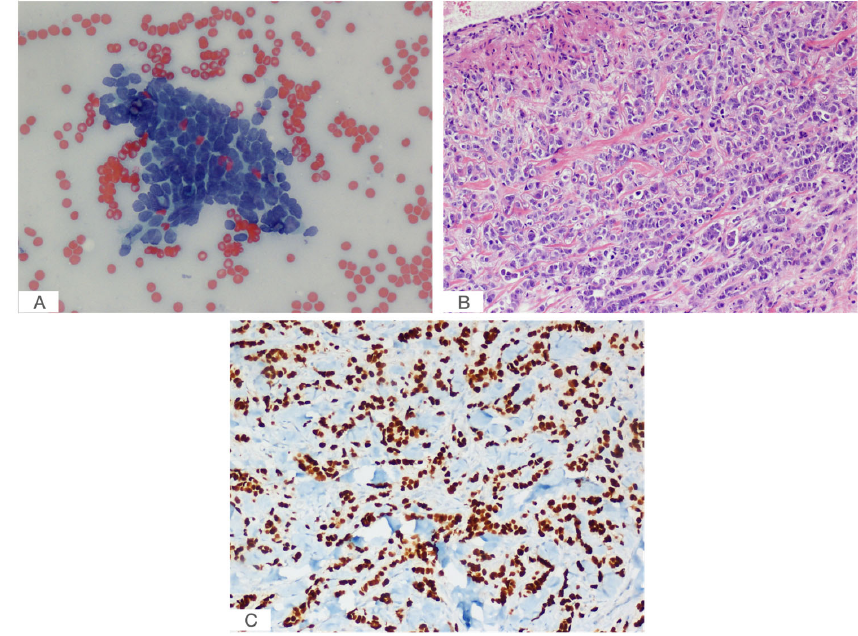
Figure 3. ( A ) Papanicolau ‐ stained FNAC of the right thyroid lobe nodule (40× magnification); ( B ) hematoxylin and eosin (H&E) staining of the right thyroid lobe revealed malignant epithelial cells (20× magnification); ( C ) IHC staining showed that malignant cells in thyroid were positive for GATA3 (20× magnification).